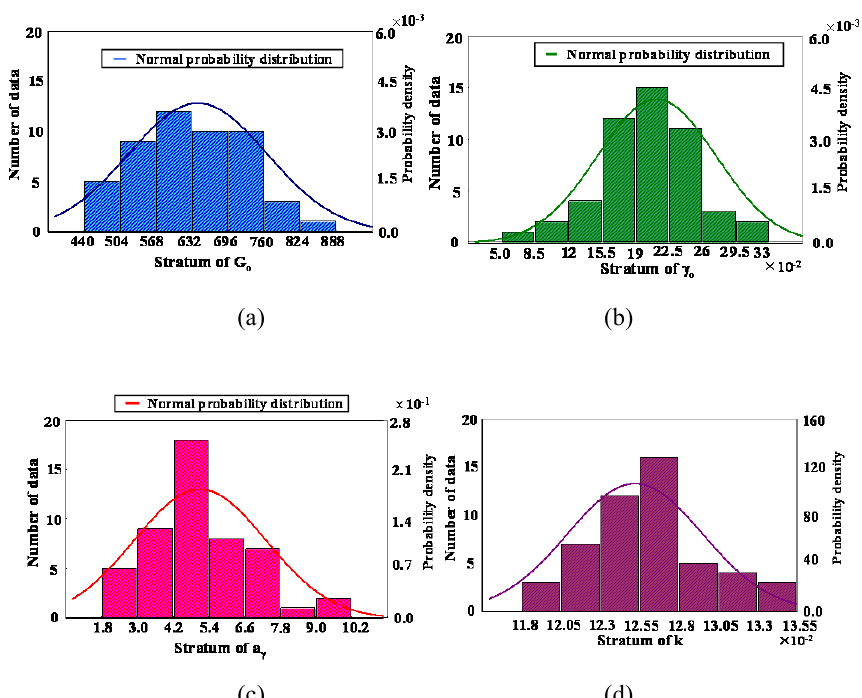
and a and the o γ and a and the minimum o γ